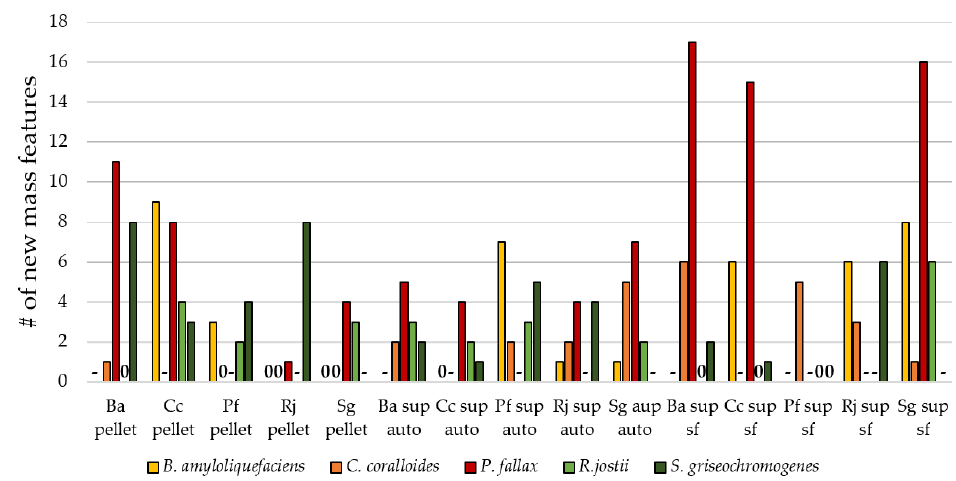
Figure 5. Number of new mass features in extracts of biotic additive experiments. A ‘-’ indicates not tested with this bacterium, while ‘0’ relates to no new mass features. The bacteria are indicated as follows: Ba = B. amyloliquefaciens , Cc = C. coralloides , Pf = P. fallax , Rj = R. jostii , and Sg = S. griseochromogenes. Any new mass feature had to be present in both biological duplicates and its MS signal had to surpass an intensity of 10 5 to be considered for the number of new mass features presented in this diagram. Therefore, this diagram only shows the number of reproducibly detected mass features.